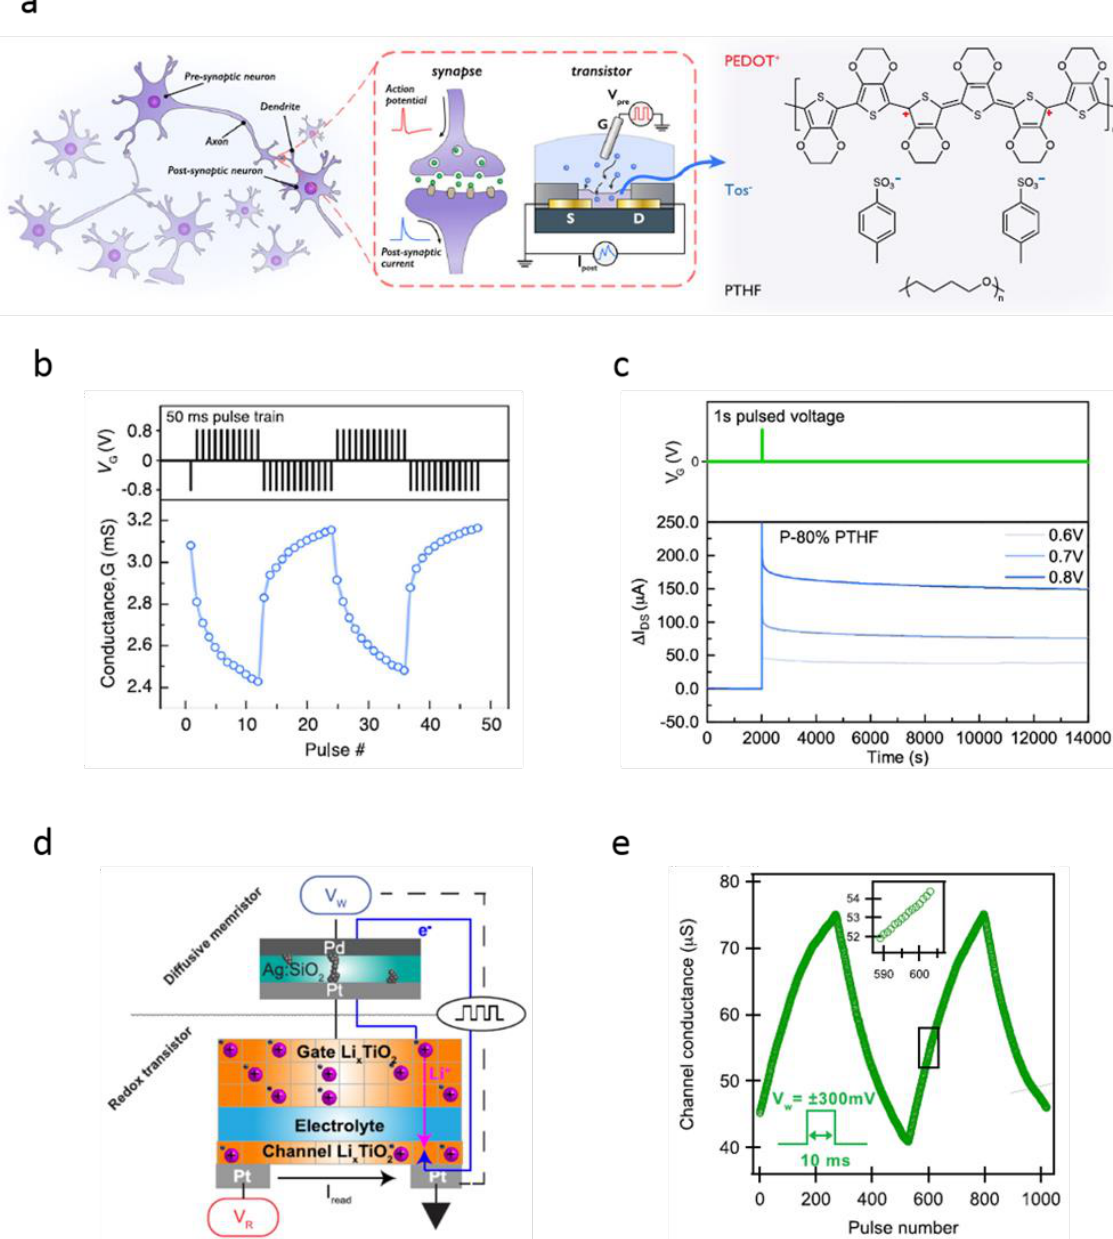
Figure 10. ( a ) Biological synapses and ECRAM – based synaptic device and the chemical structures of PEDOT + , Tos - , and PTHF. ( b ) Potentiation – depression curves of an ECRAM – based synaptic device with PEDOT:Tos/P – 80 % PTHF as the active channel. These curves show 12 discrete states by injecting a writing voltage with ultra-low amplitude (+ 0.8 and – 0.8 V). ( c ) Nonvolatile characteristic of the ECRAM-based synaptic device with PEDOT:Tos/P – 80 % PTHF as the active channel under pulse stimulation with different amplitudes (0.6, 0.7, and 0.8 V). Reprinted/adapted with permission from Reference [54]. 2021, Springer Nature. ( d ) Schematic illustration of a composite system of an inorganic redox transistor and a diffusive memristor. ( e ) Potentiation – depression curves of a composite system of an inorganic redox transistor and a diffusive memristor displaying nearly perfect linearity and low cycle-to-cycle variability under an injected pulse train with a fixed ± 300 mV amplitude and 10 ms duration. Reprinted/adapted with permission from Reference [55]. 2019, American Chemical Society.